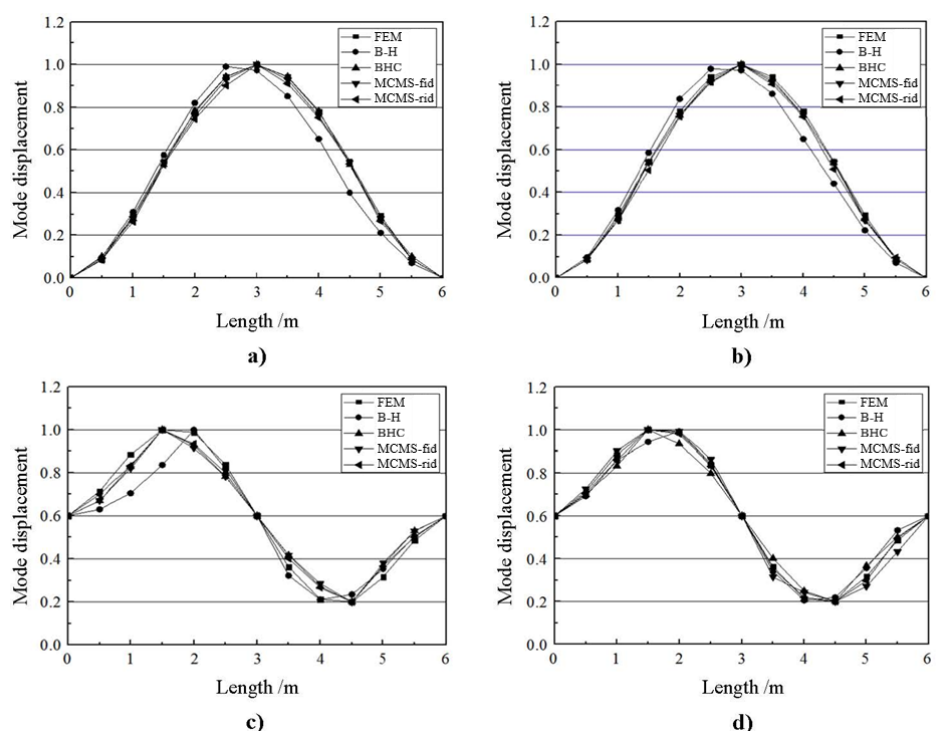
= 39.10 Hz); ( b ) 1st 1 = 104.63 Hz); ( d ) 2nd mode in 3